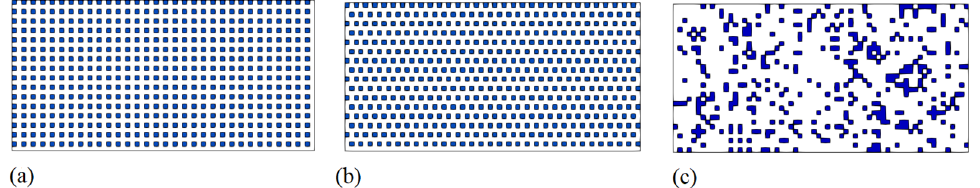
Figure 2. Illustration of the distribution geometry in a post-type SHS: ( a ) aligned, ( b ) staggered, and ( c ) random models.